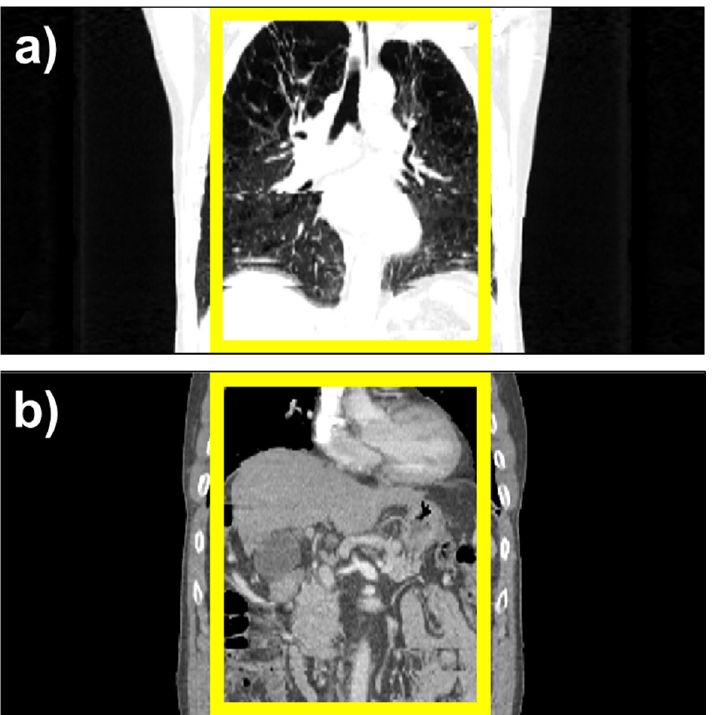
Fig 12. Coronal view of sorted 4DCT and its evaluation regions for performance comparison of the sorting algorithm.